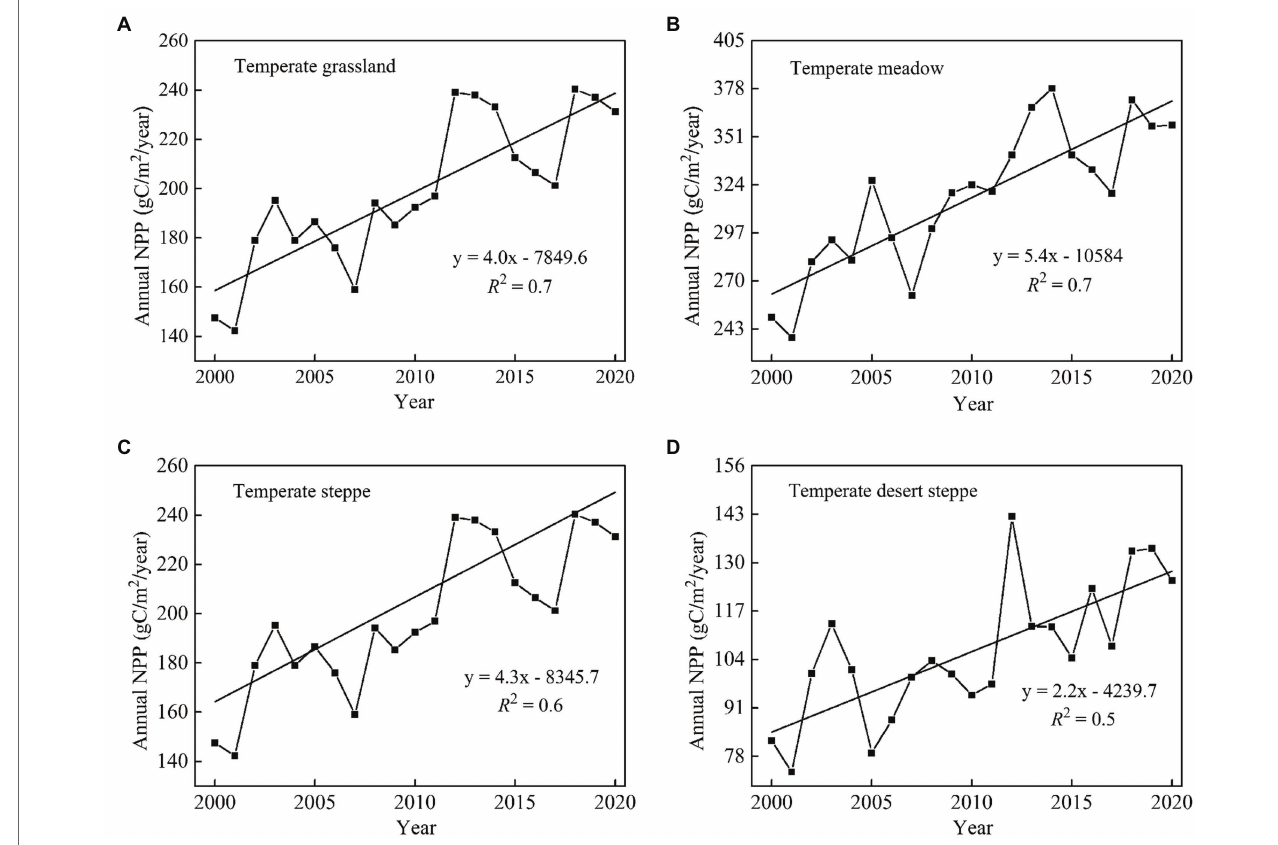
FIGURE 3 | Temporal trends in annual net primary productivity (NPP; gC/m 2 /year) of temperate grassland (A) , temperate meadow (B) , temperate steppe (C) , and temperate desert steppe (D) in China’s temperate grassland region. during